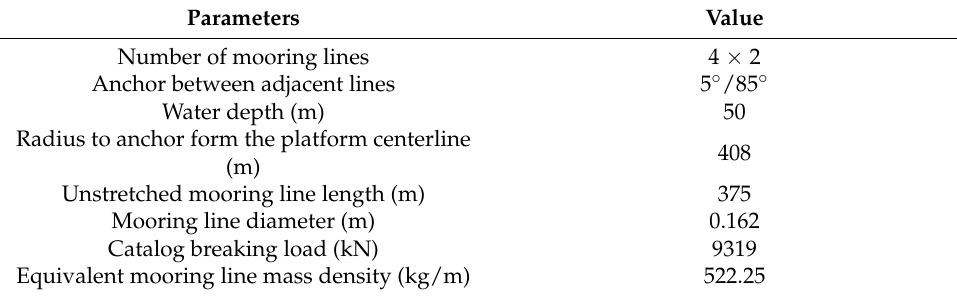
Table 4. Properties of the mooring system.